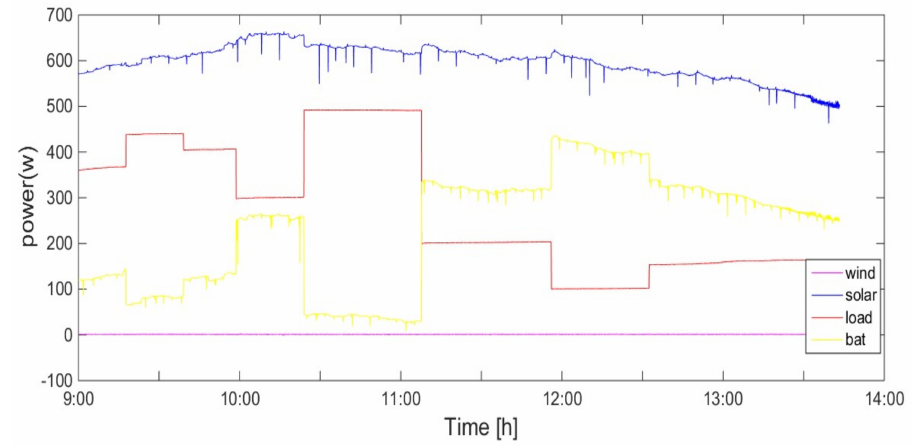
Figure 15. Power curves in scenario 3.